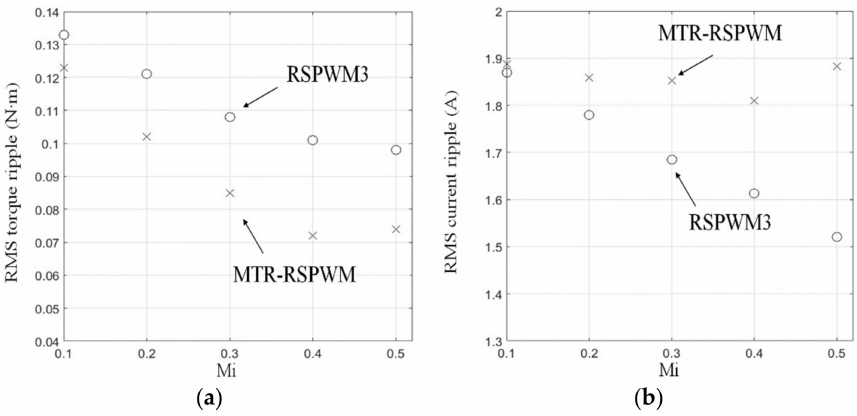
Figure 13. Experimental results: ( a ) RMS torque ripple; ( b ) RMS current